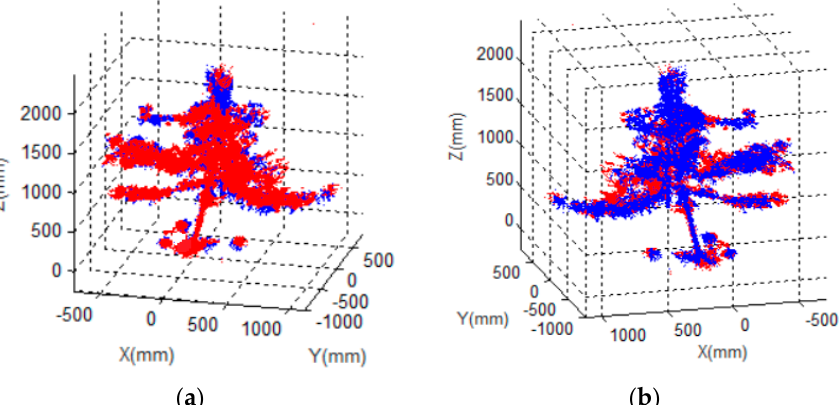
Figure 6. 3D point cloud image after coarse registration: ( a ) point cloud with double-visual-angle coarse registration (visual angle 1); ( b ) point cloud with double-visual-angle coarse registration (visual angle 2).